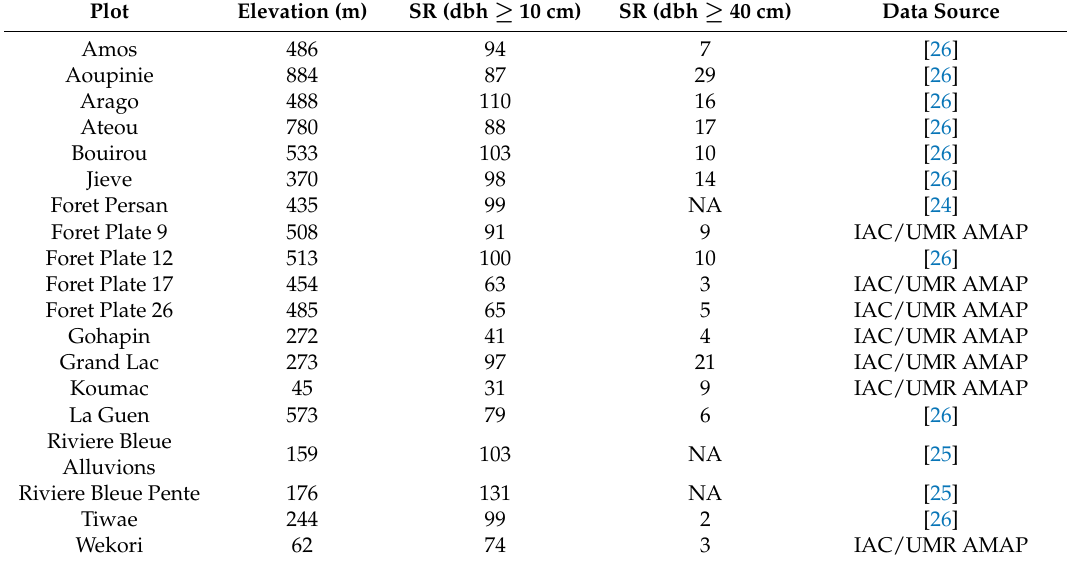
Table 1. Summary of the 19 plots located in New Caledonia used to calculate correlation between normalized difference vegetation index (NDVI) and species richness (SR). The data source ‘IAC/UMR AMAP’ refers to authors’